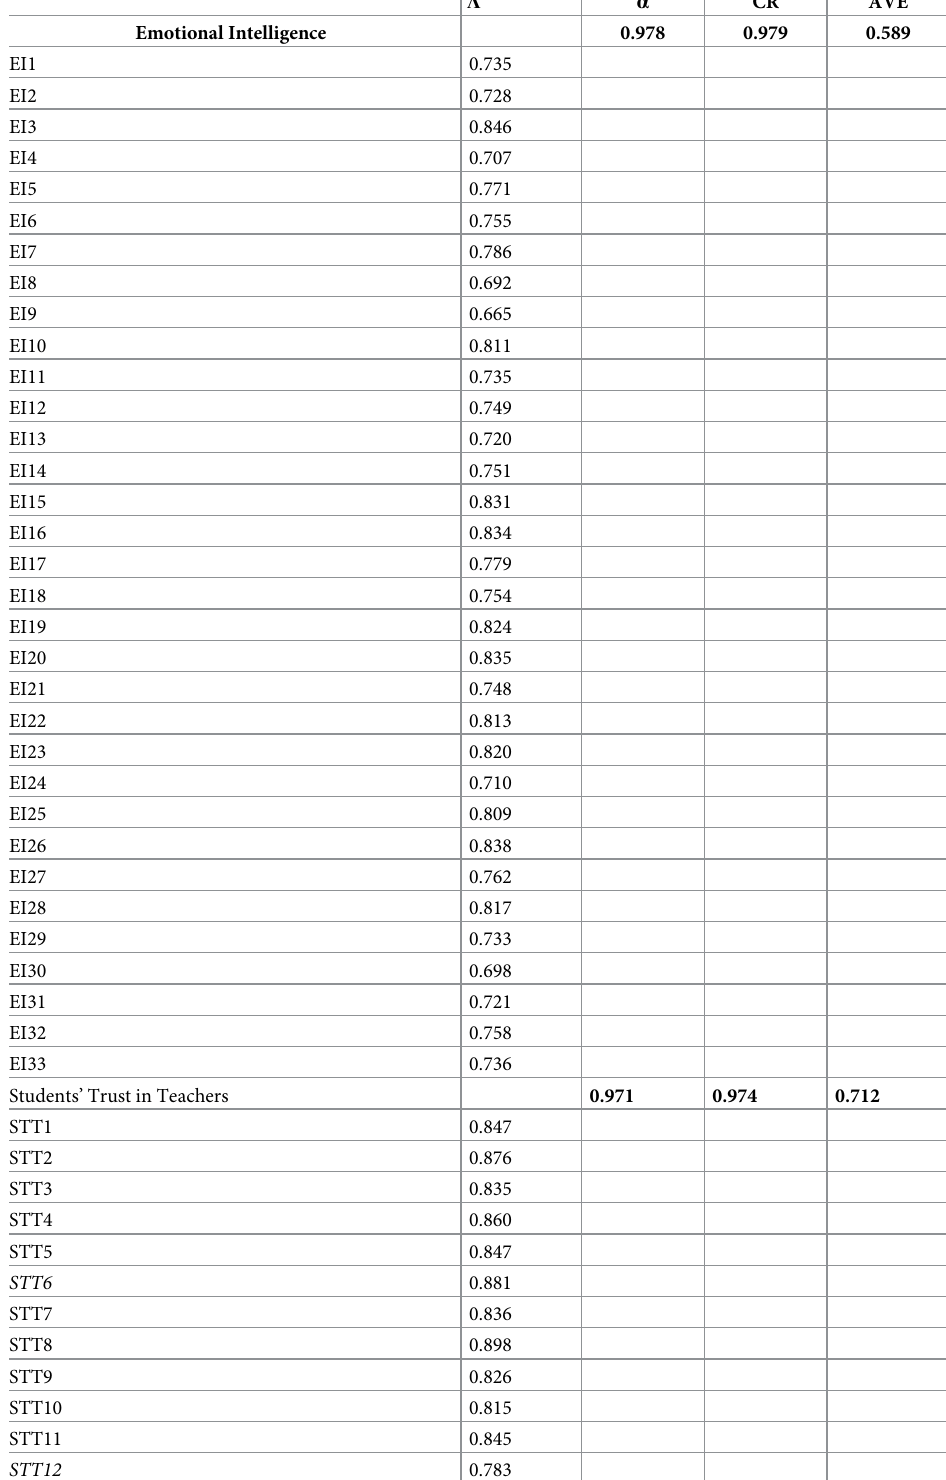
Table 4. Item loadings, reliability and convergent